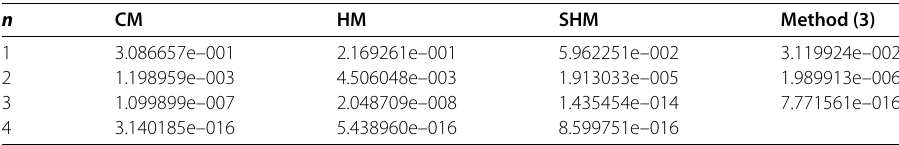
Table 1 The iterative errors ( (cid:2) x n – x ∗ (cid:2) 2 ) of various methods n CM HM SHM Method (3)